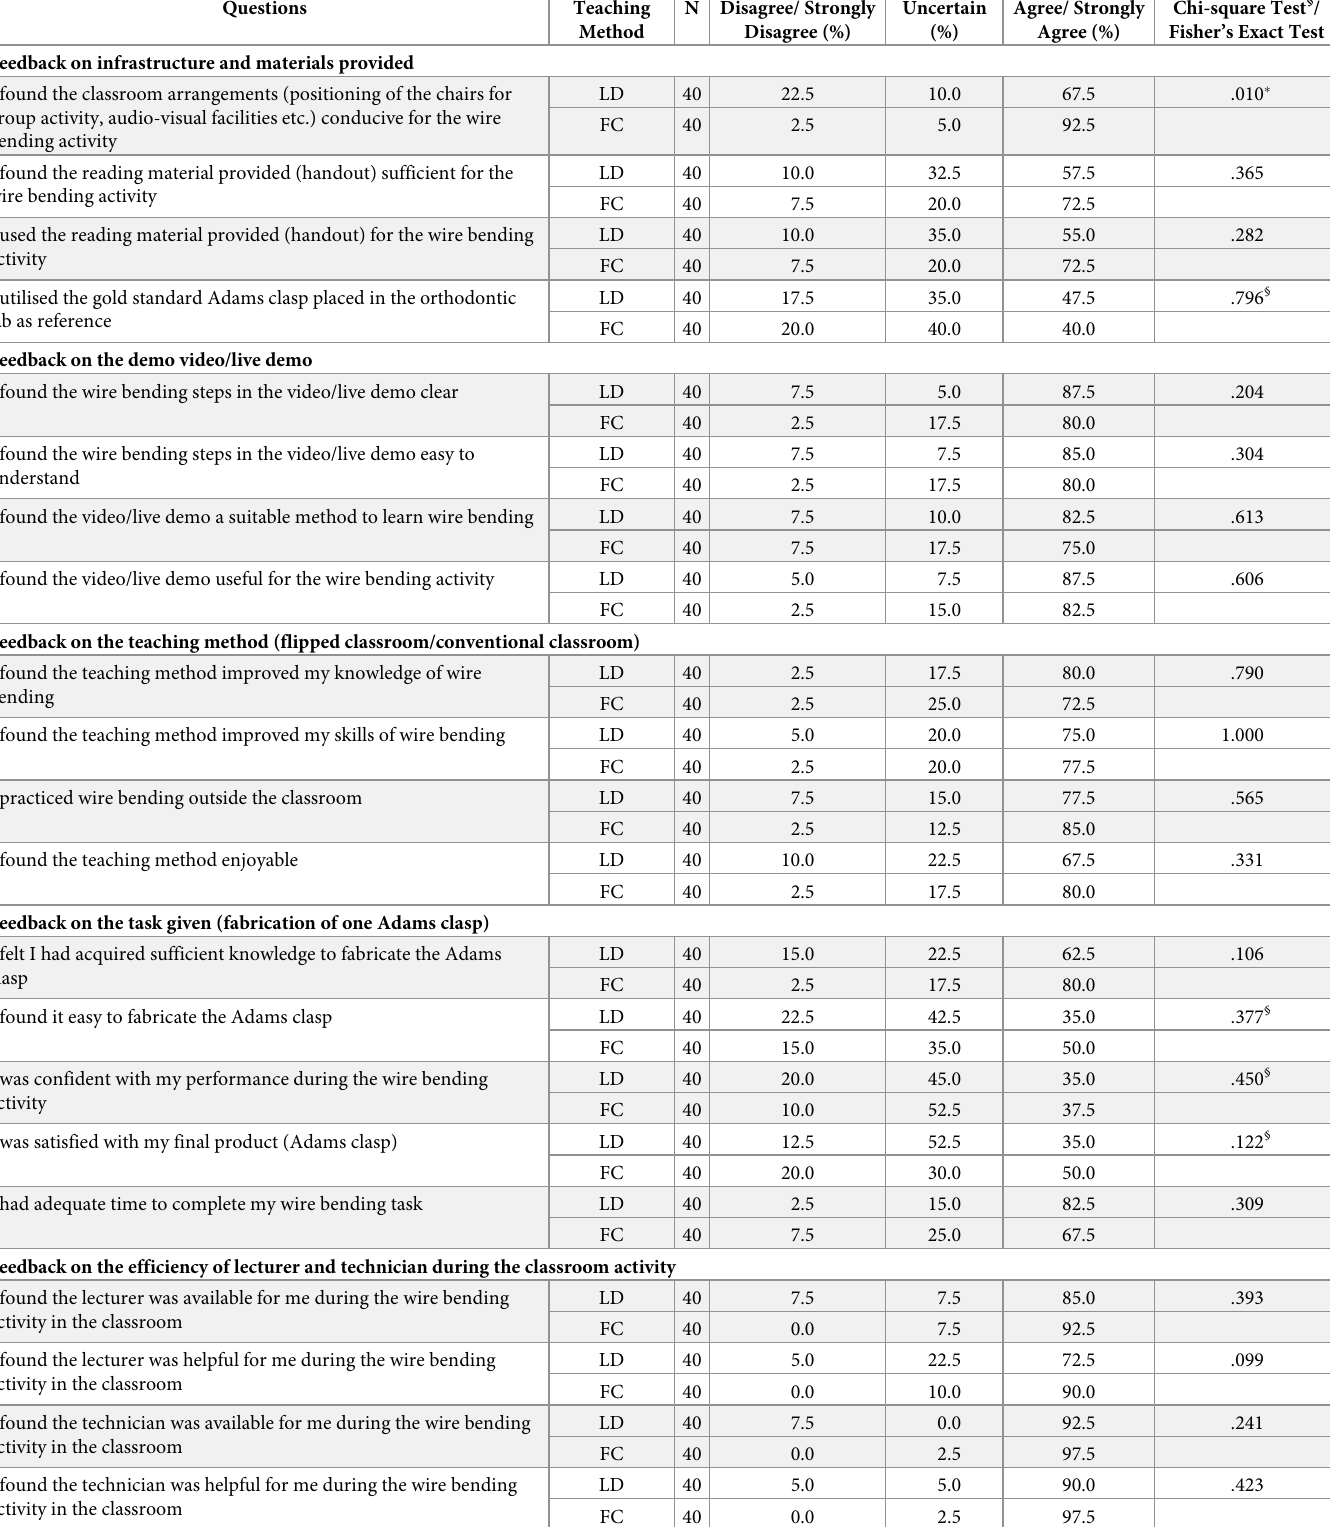
Table 4. Students’ perception of the live demonstration and flipped classroom